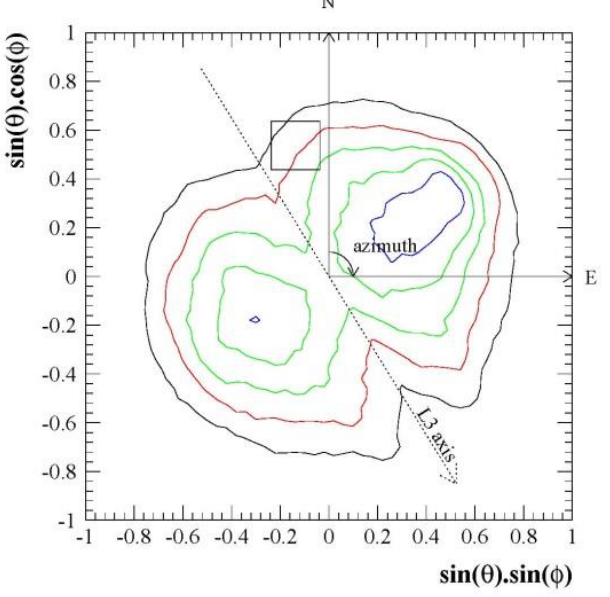
Figure 3. The distribution of the arrival directions of muons observed by the L3 + C detector. The contour lines indicate directions having an equal event rate. The square represents the sky cell No. 48.